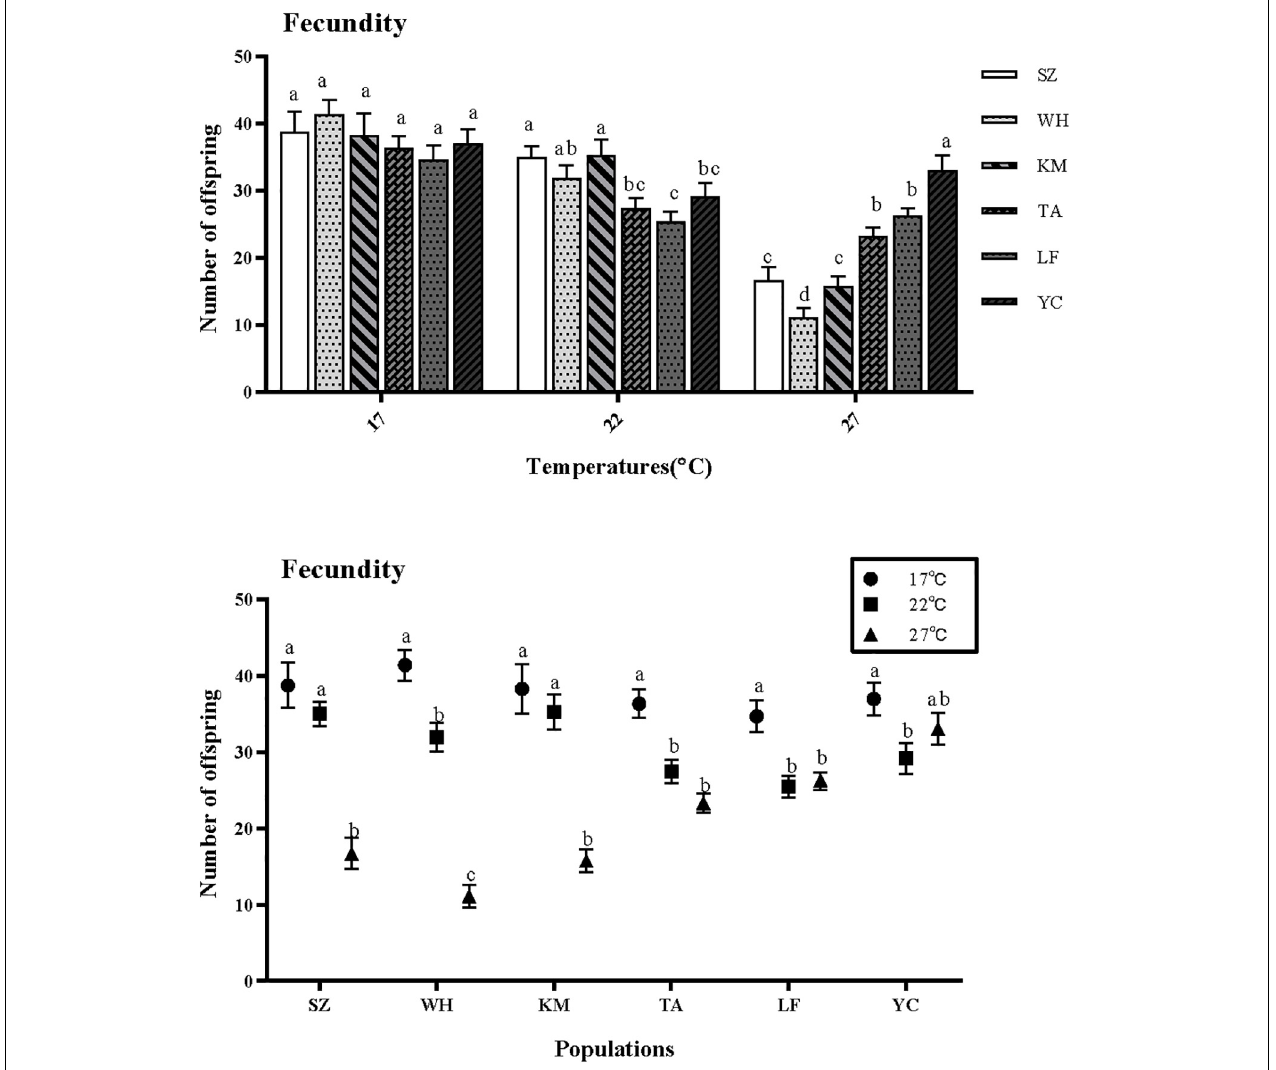
FIGURE 4 | Effect of different temperatures on the fecundity of S. miscanthi . SZ, Suzhou; WH, Wuhan; KM, Kunming; TA, Tai’an; LF, Langfang; YC, Yinchuan.